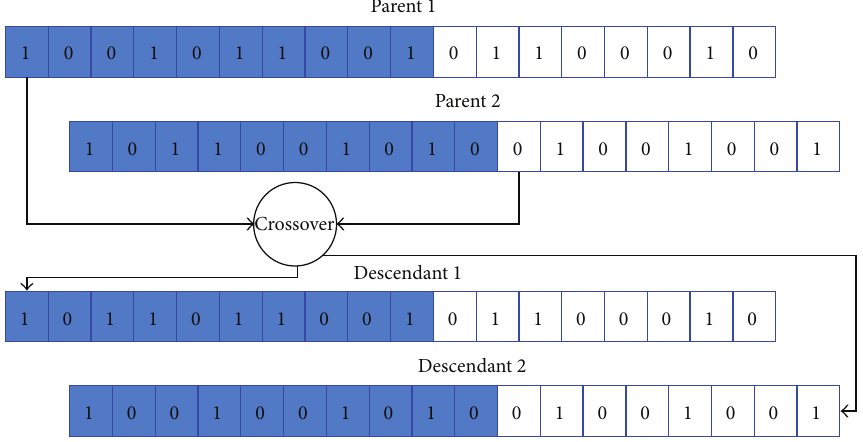
Figure 6: Pick-and-replace crossover